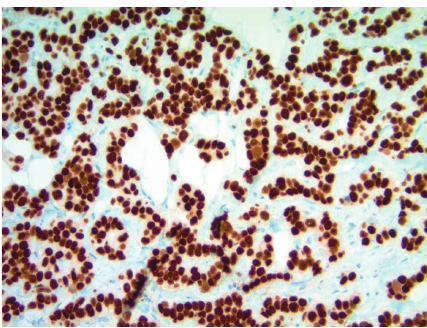
Figure 6: Photomicrograph of tissue section from the patient’s known invasive ductal carcinoma (GATA3 immunohistochemistry, original magnification 200x).